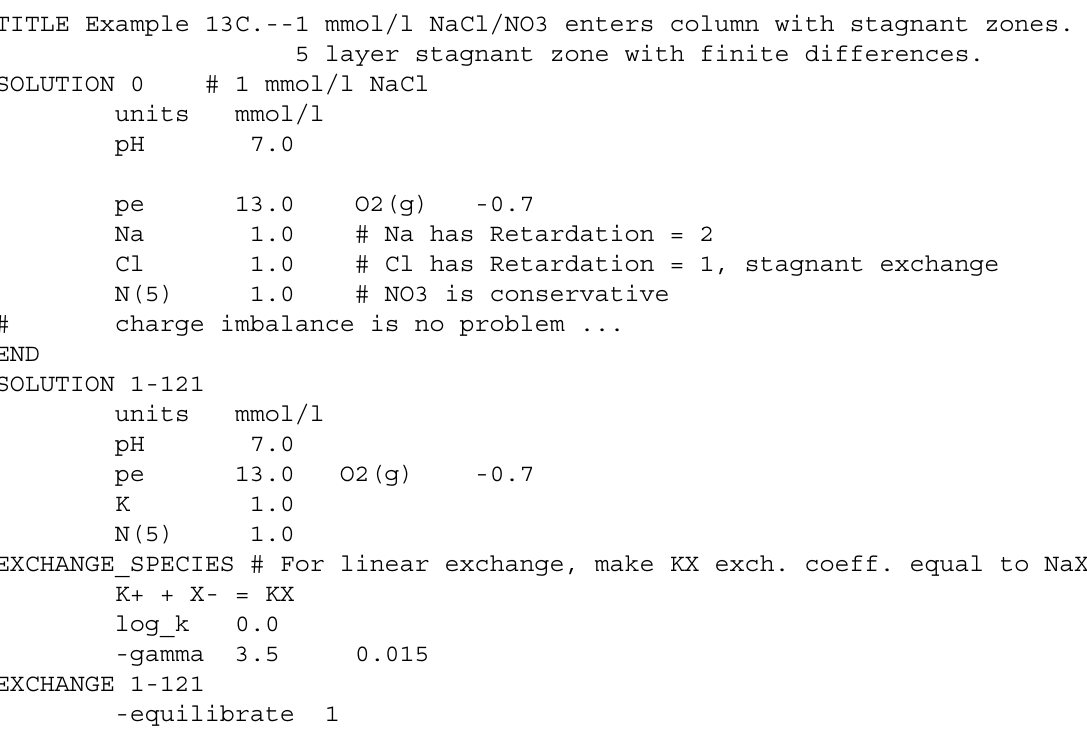
Table 35. Input file for example 13C: Stagnant zone with diffusion calculated by finite differences (partial